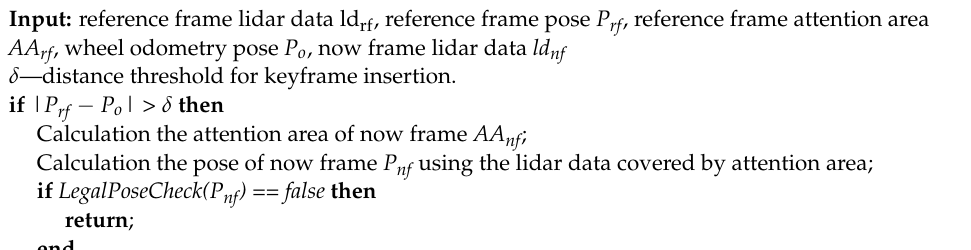
Algorithm 1: The Proposed Algorithm.